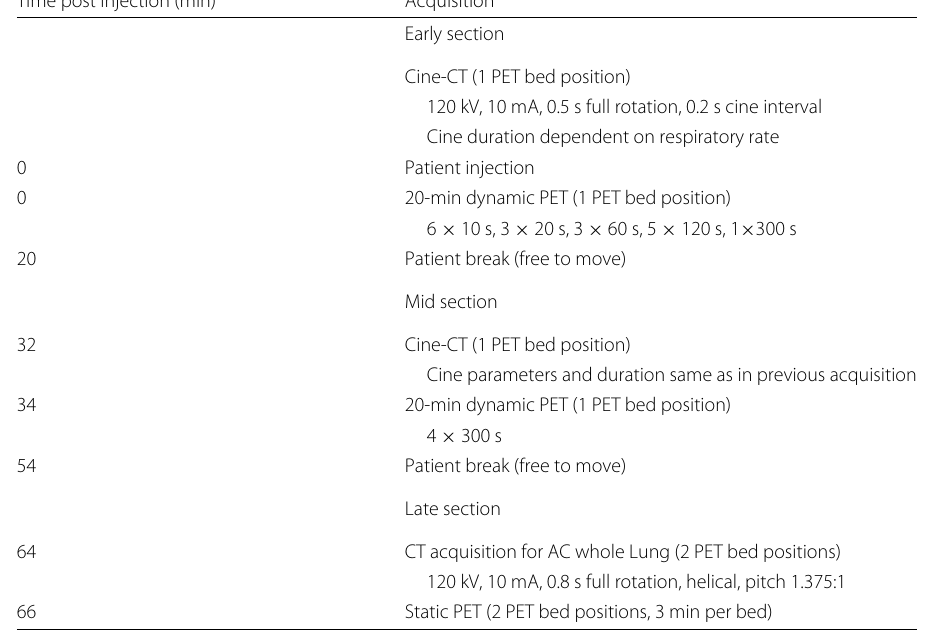
Table 1 Patient acquisition